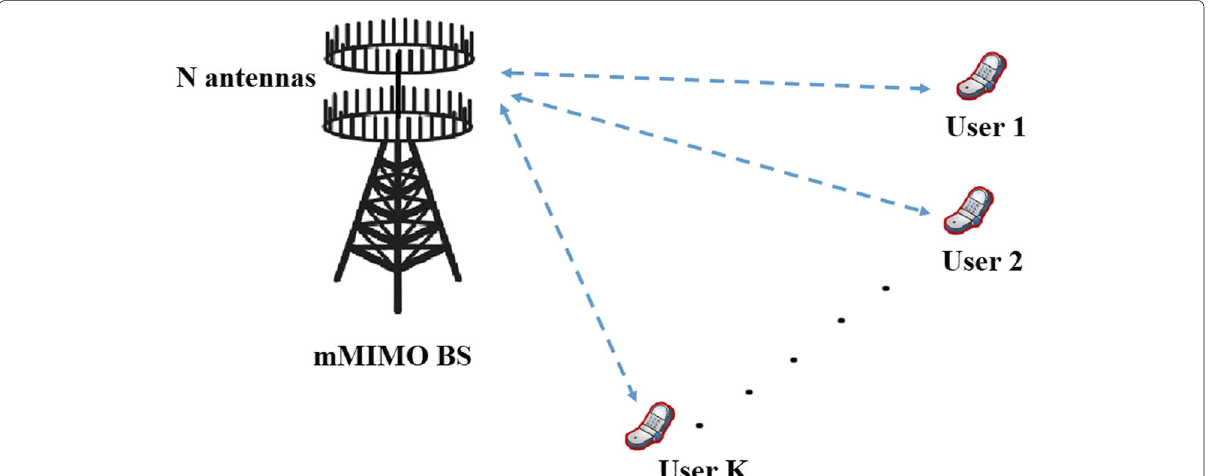
Fig. 1 Massive MIMO system model in downlink, where K and N denote number of single antenna users and number of antennas per BS, respectively. This figure describes the utilized system model which is one BS with N antennas that serve K single antenna